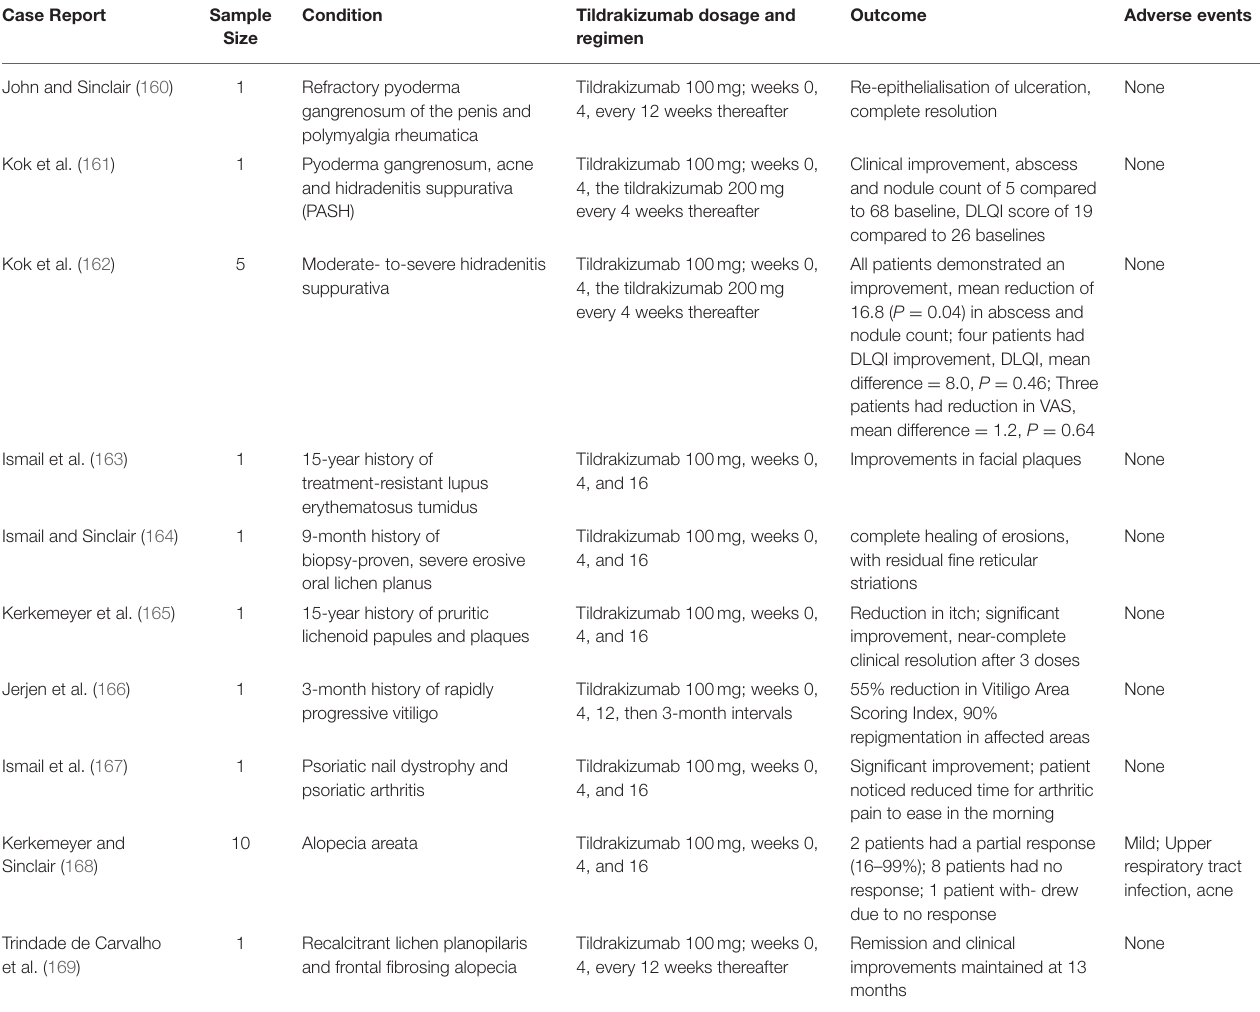
TABLE 5 | Clinical cases reported in the literature discussing the off label uses of tildrakizumab. Case